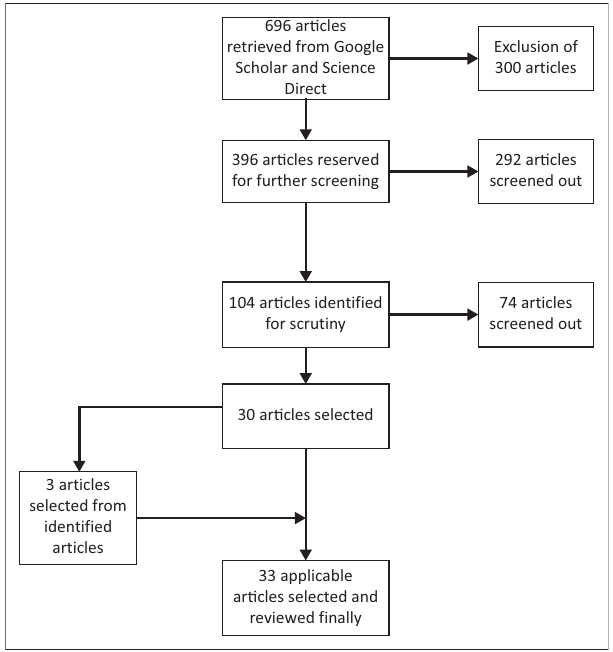
FIGURE 1: Selection and screening of publication process flow